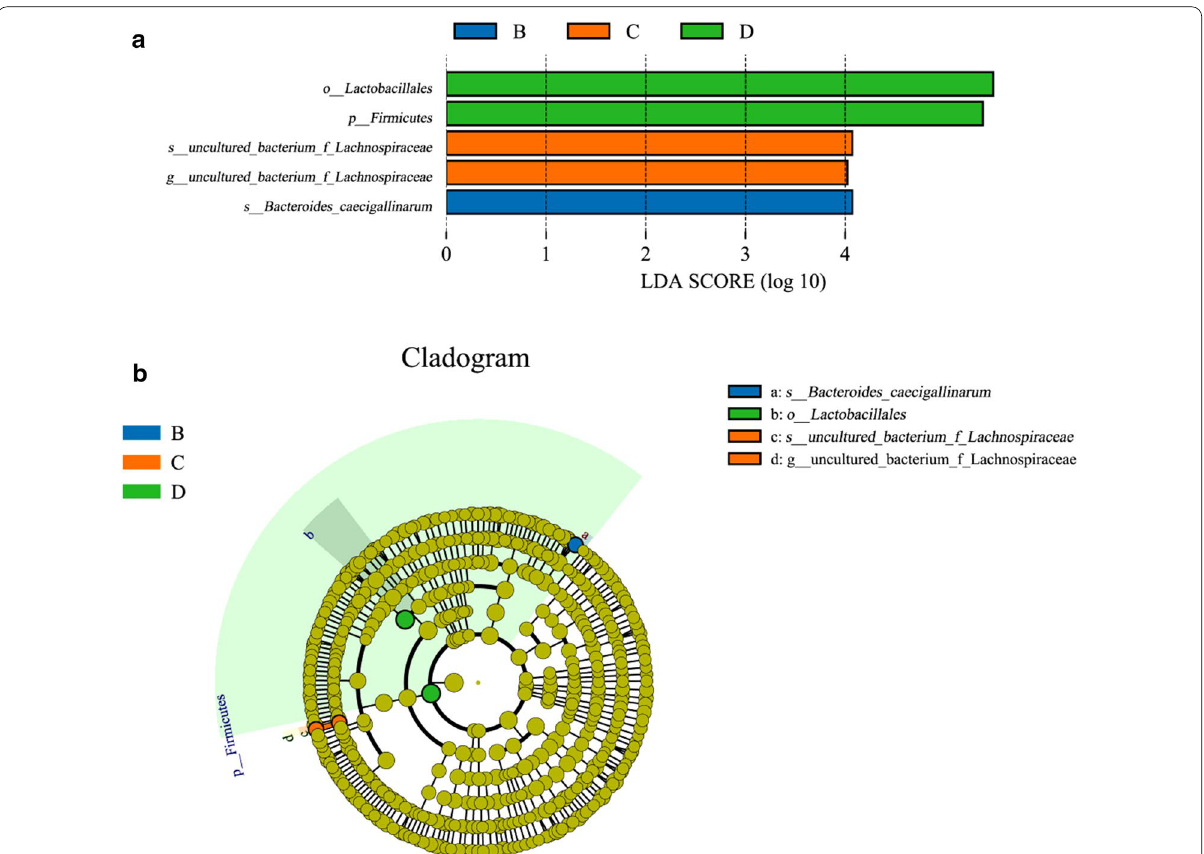
Fig. 5 The differential taxa of gut microbiota after added purslane. a LDA value distribution histogram. b Cladogram of LEfSe analysis. The circle radiating from inside to outside of the cladogram represent the classification levels from phylum to species. Each small circle at different classification levels represents a classification at that level, and the diameter of the circle is proportional to the relative abundance. The blue, orange, and green circles represent the bacteria enriched in groups B, C and D, respectively, whereas the yellow circles represent the taxa with no significant